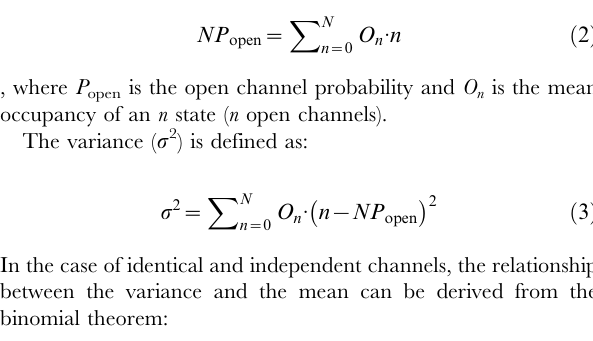
Figure S2 Kinetic models for two non-independent channels (A), and for two non-identical channels (B). C for closed channel, and O for open channel. (PDF) Figure S3 Probability of fewer than three simultaneous openings being observed in three-channel patches as a function of record length for a representative simulated record. N max is the maximum number of channel openings observed in the record. (PDF) Figure S4 Conditional closed dwell time distributions for independent channels when the other channel is closed (YC, black line) and when the other channel is open (YO, red line). (PDF) Figure S5 Integrated convolution function relating YO and YC for a representative K ATP channel record. (PDF) Figure S6 Models used for simulation of channel noise in bursting channels. C is the long-lived closed state, C* is the short-lived closed state, and O is the open state. A. Model used for simulations of channel noise in two non-independent bursting channels. The opening rate is decreased when the other channel is already open (perturbed rate constants shown in red). B. Model used for simulations of channel noise in two non-identical bursting channels. The opening rate of one channel is 2-fold less than that of the other channel (smaller rate constant shown in red). (PDF) Figure S7 Clusters of openings containing no more than one simultaneous opening do not exhibit kinetic hetero- geneity. A and B. Closed ( A ) and open ( B ) dwell time distributions; solid black ( A ) and red ( B ) lines are fits to a model with equilibration between single open and closed states. C and D. Distributions of mean closed ( C ) and open ( D ) times within clusters, for clusters with at least 10 opening events. E and F. Mean closed ( E ) and open ( F ) times within clusters as a function of time within a record. (PDF) Figure S8 Kinetic properties of experimental two- channel records differ from those of superposed sin- gle-channel records. Blue lines mark the shortest mean closed dwell time ( A and B ) or mean conditional closed dwell time ( C and D ). A. Dwell time distributions of a two-channel record for ‘‘both channels closed’’ (black) and ‘‘one channel open’’ (red). B. Dwell time distributions of a superposition of two single channels for ‘‘both channels closed’’ (black) and ‘‘one channel open’’ (red). C. Conditional dwell time distributions YC (black) and YO (red) of a two-channel record. D. Conditional dwell time distributions YC (black) and YO (red) of a superposition of two single channels. Figure S9 Stationarity of channel activity for a typical recording. NP open was calculated for 500-ms segments. A. NP open in each segment as a function of time. No trend in NP open was observed (slope , 0.003 channels/s). B. Distribution of NP open for all segments. The distribution is unimodal, indicating a lack of discrete mode shifts within the recording. Figure S10 Distributions of maximum number of open channels and NP open for recordings of K ATP